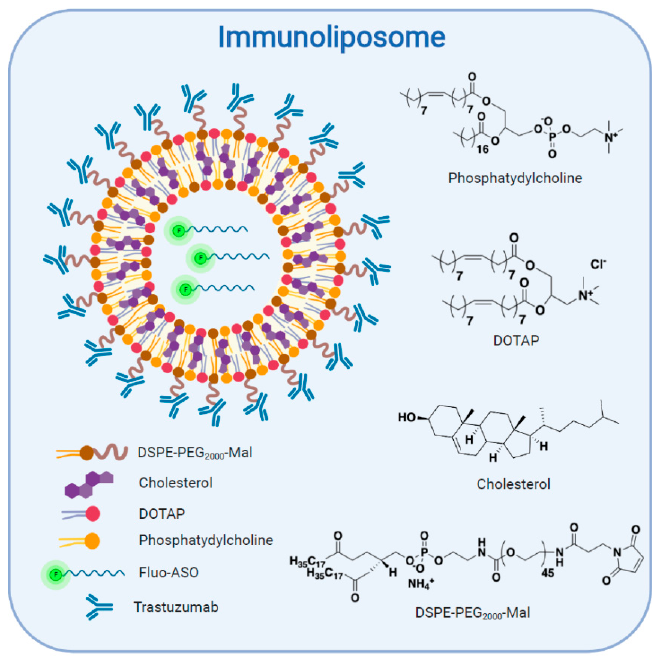
Figure 1. Schematic representation of the immunoliposome structure and composition.